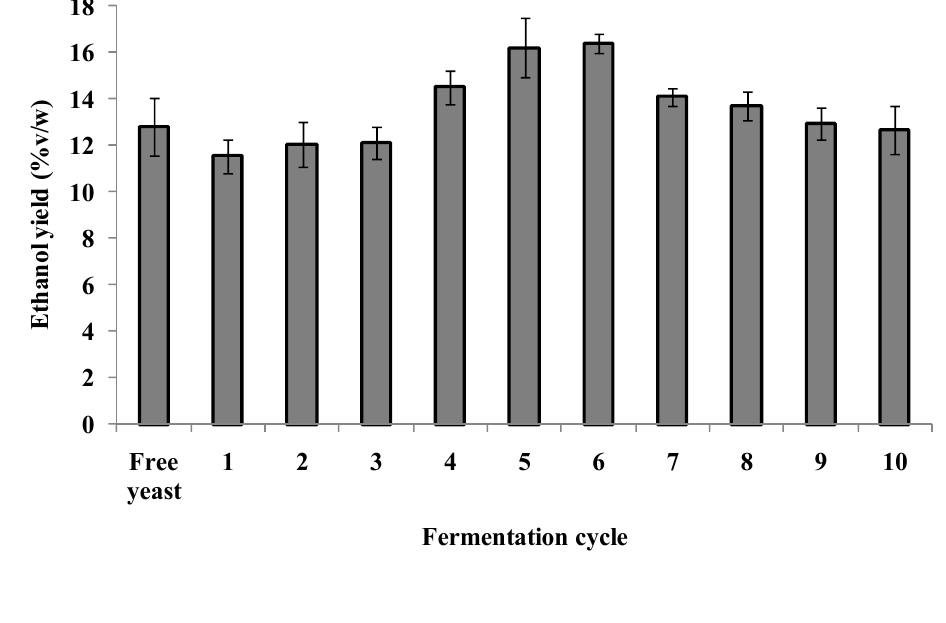
Figure 4. Fermentation efficiency of free yeast cells and re-used yeast-gellan gum